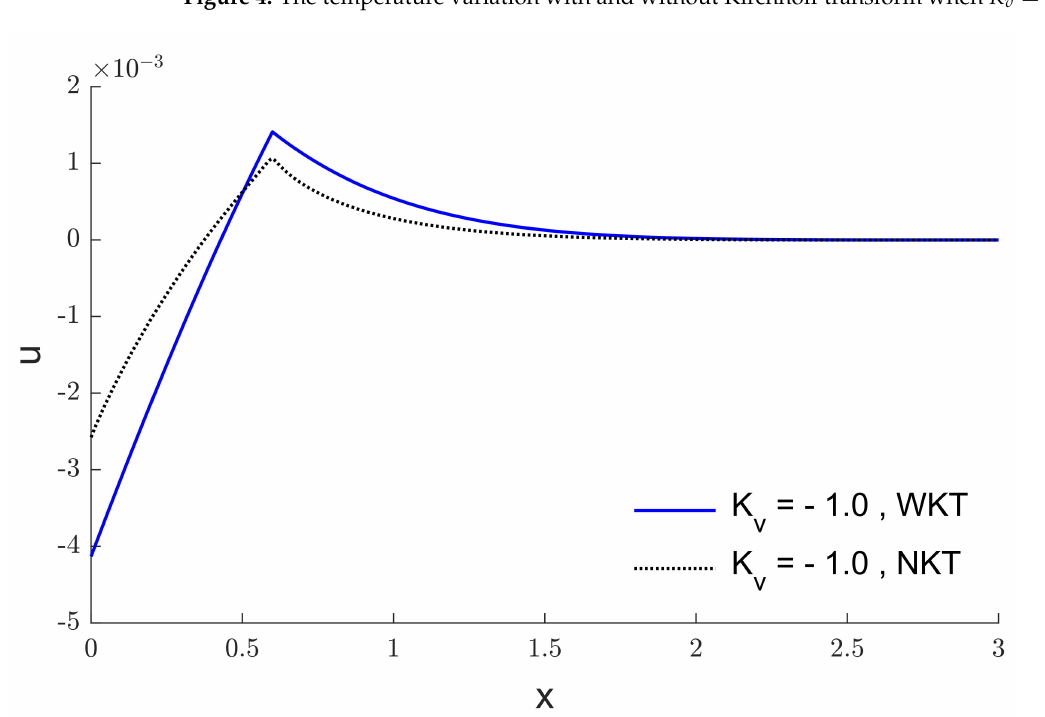
Figure 5. The displacement variation with and without Kirchhoff transform when K v = −